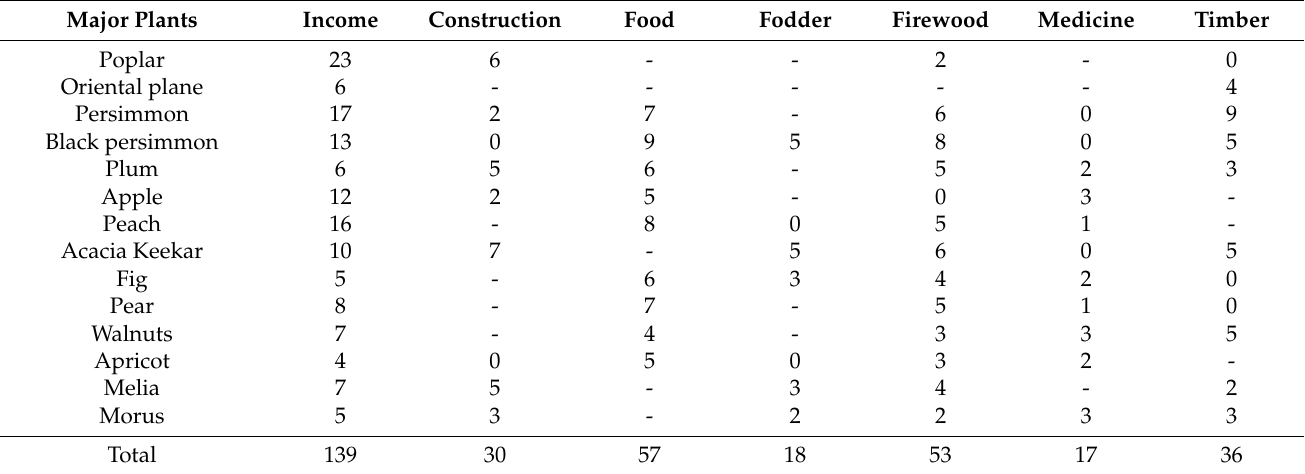
Table 2. Types of trees and benefits from these